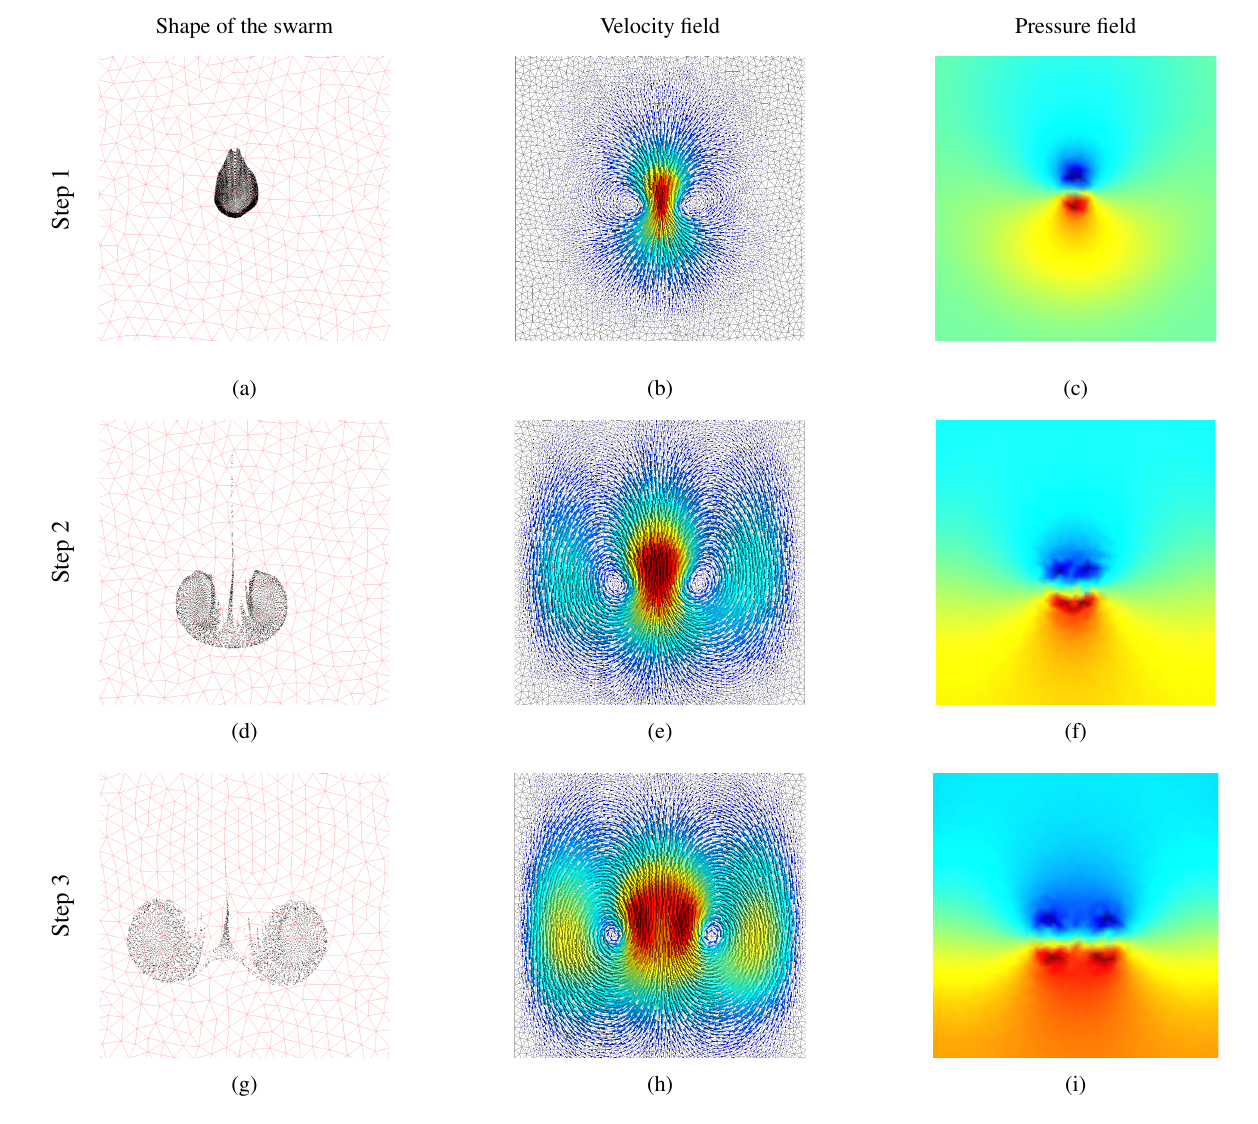
Figure 1: Evolution of a swarm made up of glass beads falling in glycerin